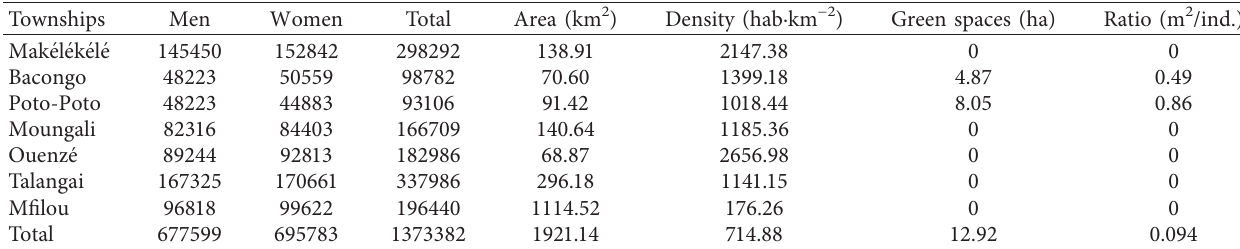
Table 3: Green space-inhabitants ratio in the municipality of